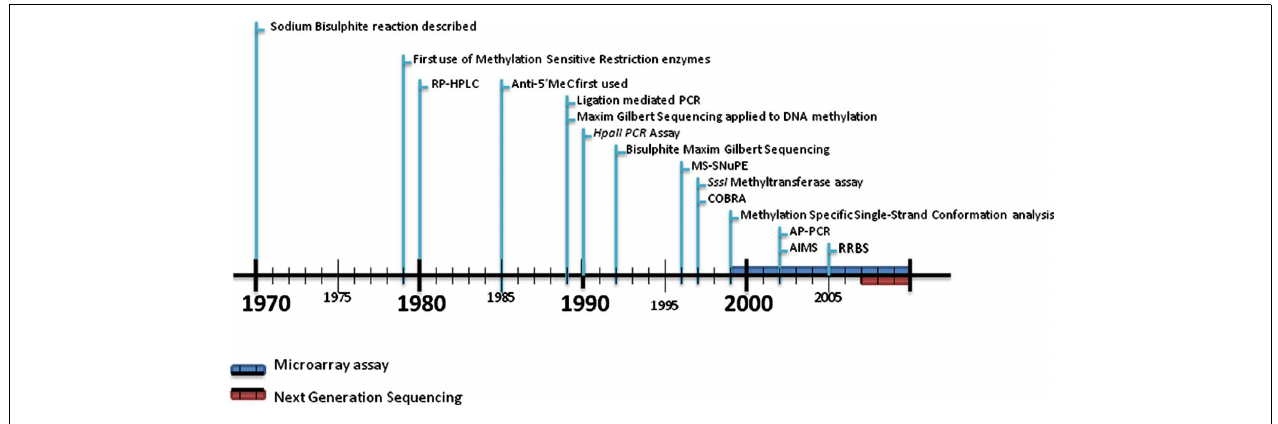
methods to these newer platforms during the 2000s. More details on microarray/beadchip technologies and next-generation sequencing are described in Tables 1 and 2 . RP-HPLC, reversed-phase high performance liquid chromatography; 5mC, 5-methylcytosine; MS-SnuPe, methylation-sensitive single nucleotide primer extension; COBRA, combined bisulfite restriction analysis; AP-PCR, arbitrarily primed PCR; AIMS, amplification of inter-methylated sites; RRBS, reduced representation bisulfite